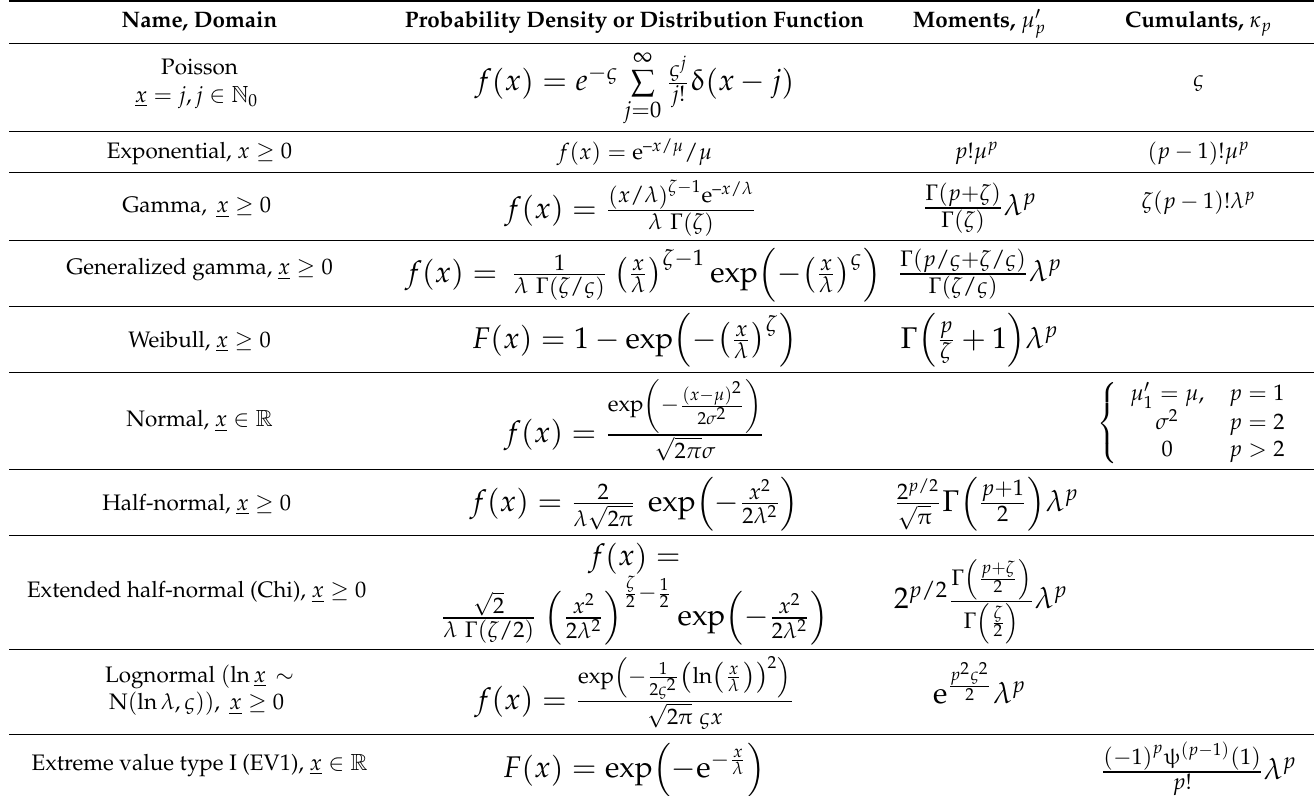
Table 3. Non-central moments and cumulants of common distributions with zero upper-tail index (all moments and cumulants